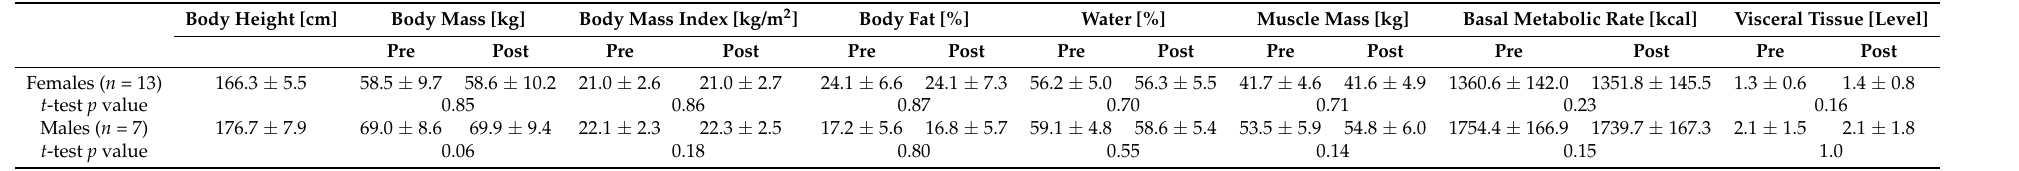
Table 1. Measurements of Tourism and Recreation students during a 14-week period of the COVID-19 pandemic. Data is presented as mean value ± standard